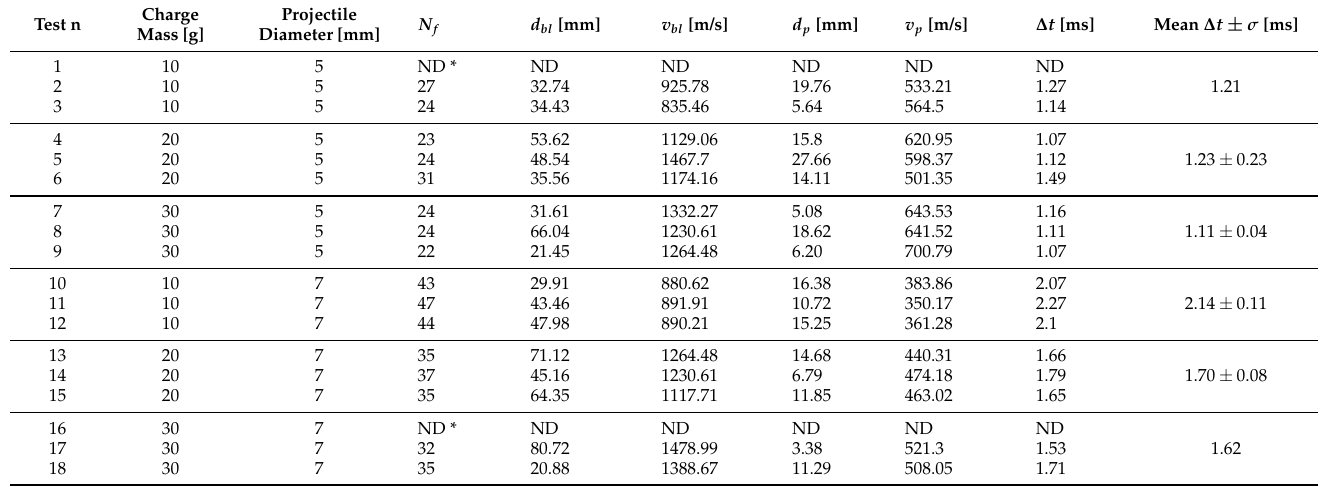
Table 1. Values of the different parameters of Equation (1) for charge masses of 10, 20, and 30 g of C4 and 5 and 7 mm diameter of the